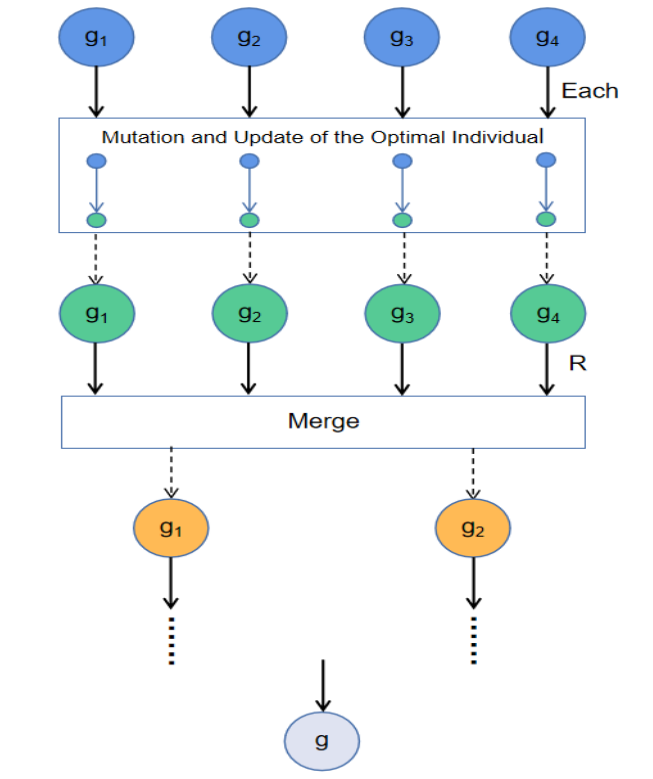
Figure 3. The running process of the population merge communication